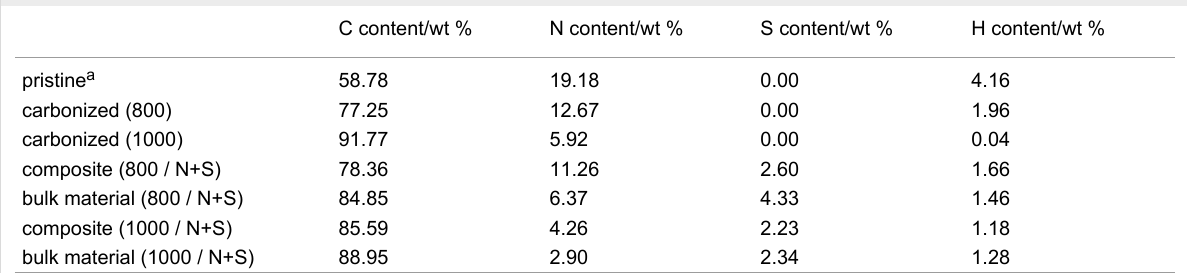
Table 2: Elemental composition of the pristine and the carbonized felt as well as the composite electrode based on elemental analysis.